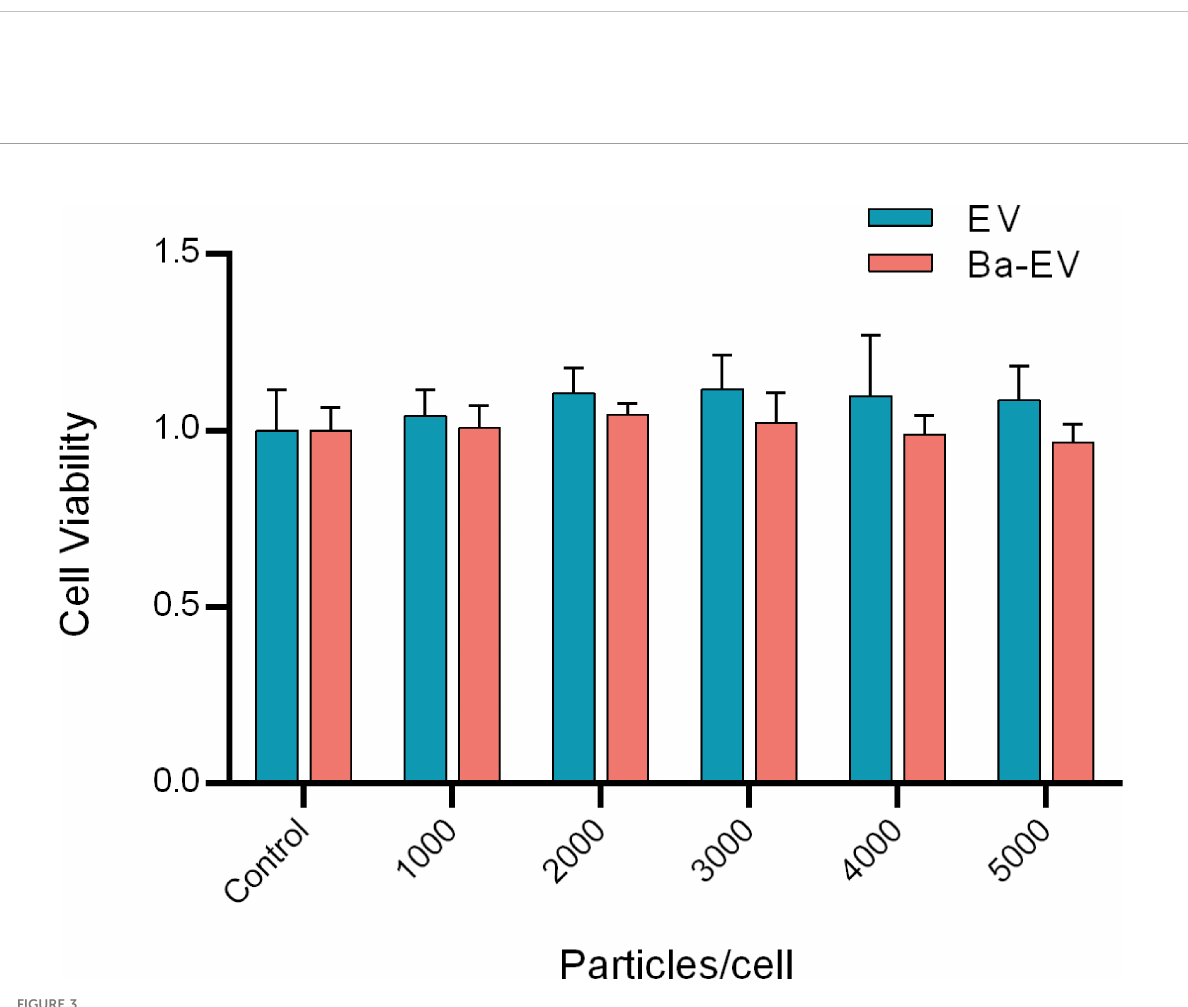
FIGURE 3 Toxicity assay of different doses of Exo and Ba-Exo on 3D4/21 cells. 3D4/21 cells were treated with different dosages (0, 1000, 2000, 3000, 4000, and 5000 particles/cell) for 24 h. Dulbecco ’ s phosphate buffered saline served as the negative control. Cell viability was determined by the cell counting kit 8 method.